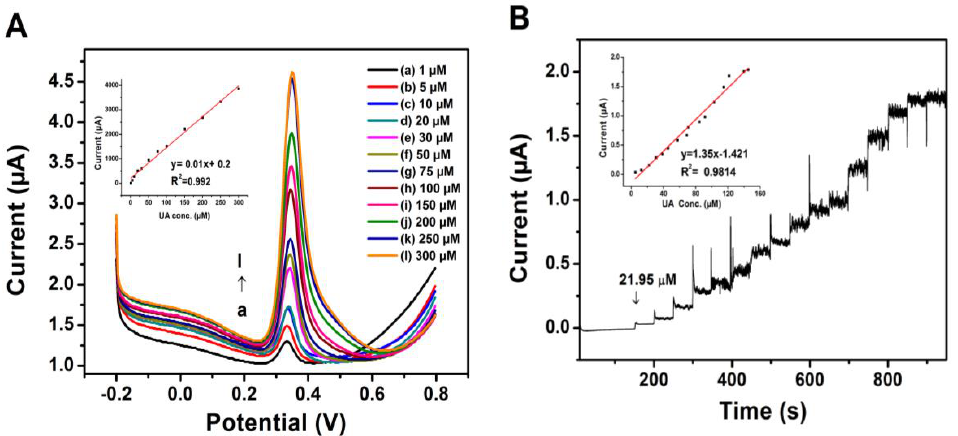
Figure 6. ( A ) DPV from 1 μM to 300 μM UA individually in 0.1 M PBS of pH 6.0 for PrGO. Inset: graph of the peak currents vs different concentration of UA in the linearity range of 1–300 μM. ( B ) Amperometric responses of PrGO by serial addition of 5 μM UA solutions into 0.1 M PBS (pH 6.0) solution at 0.5 V. Inset: the calibration curve for UA from 5 μM to 145 μM. Table 1. Performances of uric acid from different methods and materials.